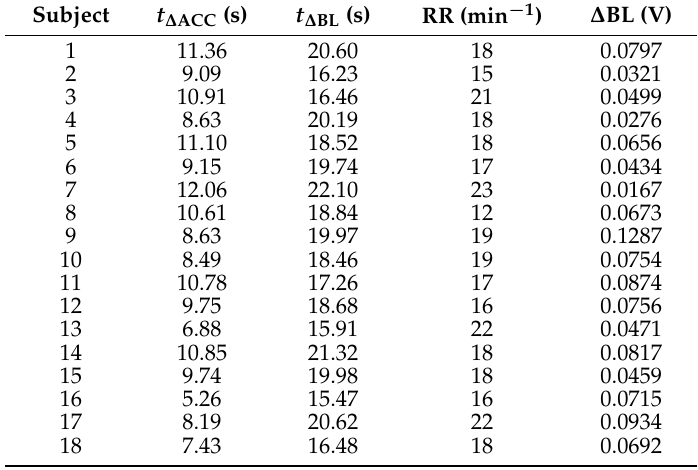
Table 6. Primary Parameters of Body Variation from Sitting Position to Standing